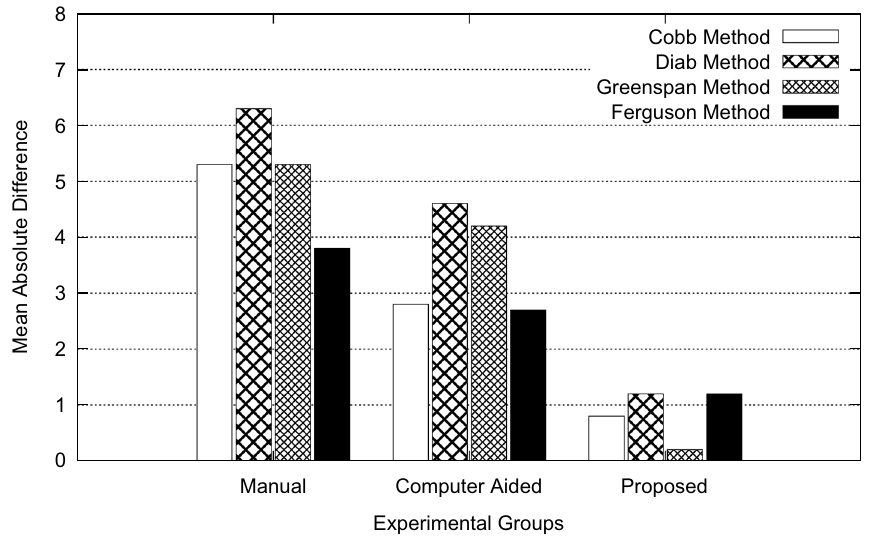
Figure 5. Type I (a) mean absolute difference (MAD) in inter observer variation.